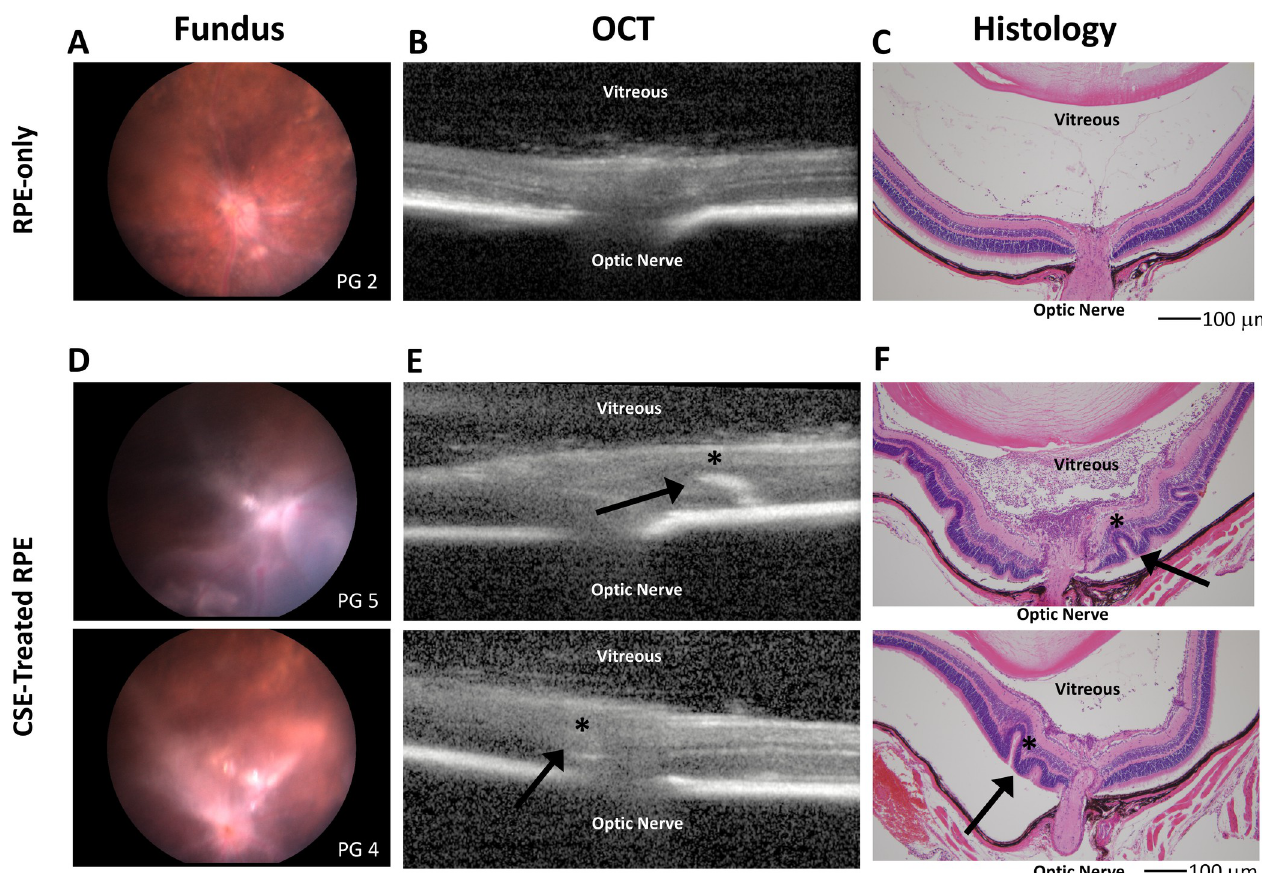
Fig 4. CSE treated RPE cell injection increased retinal folds, retinal detachment and PVR membranes thickness compared to control RPE. Fundus imaging, OCT, and histology of representative eyes from mice injected intravitreally with control RPE cells (A,B,C) vs. RPE cells treated and resuspended with 0.5% CSE (D,E,F). All images were taken at 4 weeks post-RPE injection. Intravitreal injection of CSE-treated RPE resulted in development of more severe PVR by 4 weeks with evidence of retinal folding, significant areas of detachment, and inflammatory infiltrate. The inflammatory infiltrate is especially prevalent in the vitreous of the top section in F. Arrows and � in E and F highlight retinal folds observed on OCT imaging seen in histologic cross-sections. Scale bars represent 100 microns ( μ m) in length.